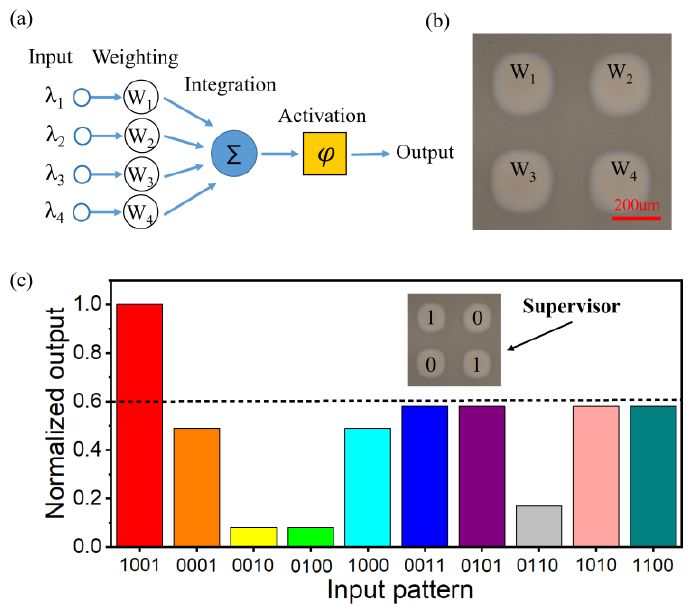
Figure 8. ( a ) Schematic diagram of realizing a single neuron. ( b ) Light microscopic view of a neuron composed of four photonic synapses. ( c ) The normalized output of the neuron is set to “1001” mode.